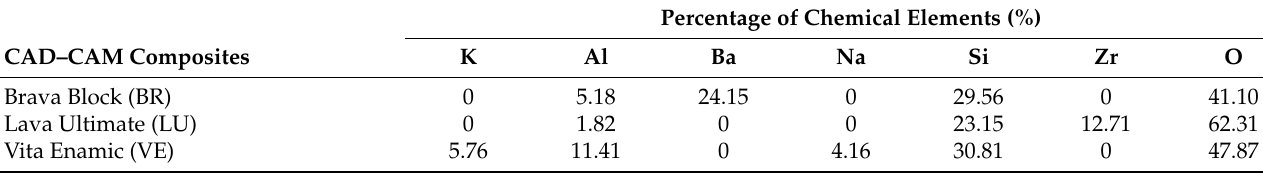
Table 7. EDS analysis of treated